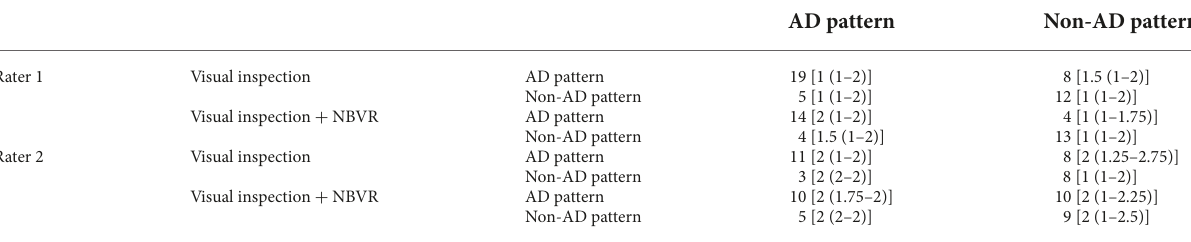
TABLE 3 Differential diagnosis of between individuals with a pattern of AD and non-AD